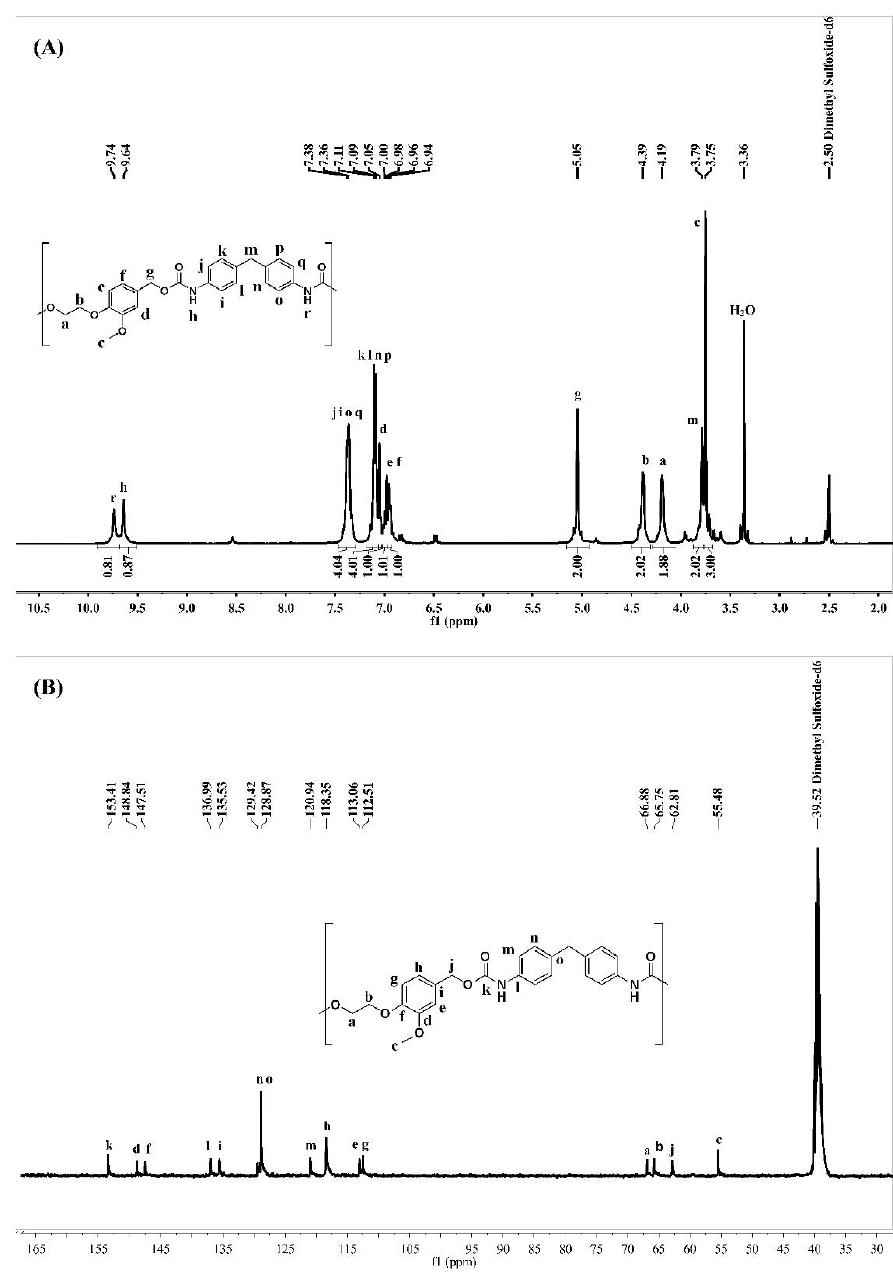
Figure 6. Comparative 1 H NMR spectra of PU-3 ( A ) and 13 C NMR spectra of PU-3 ( B ). Table 2. Test data based on the